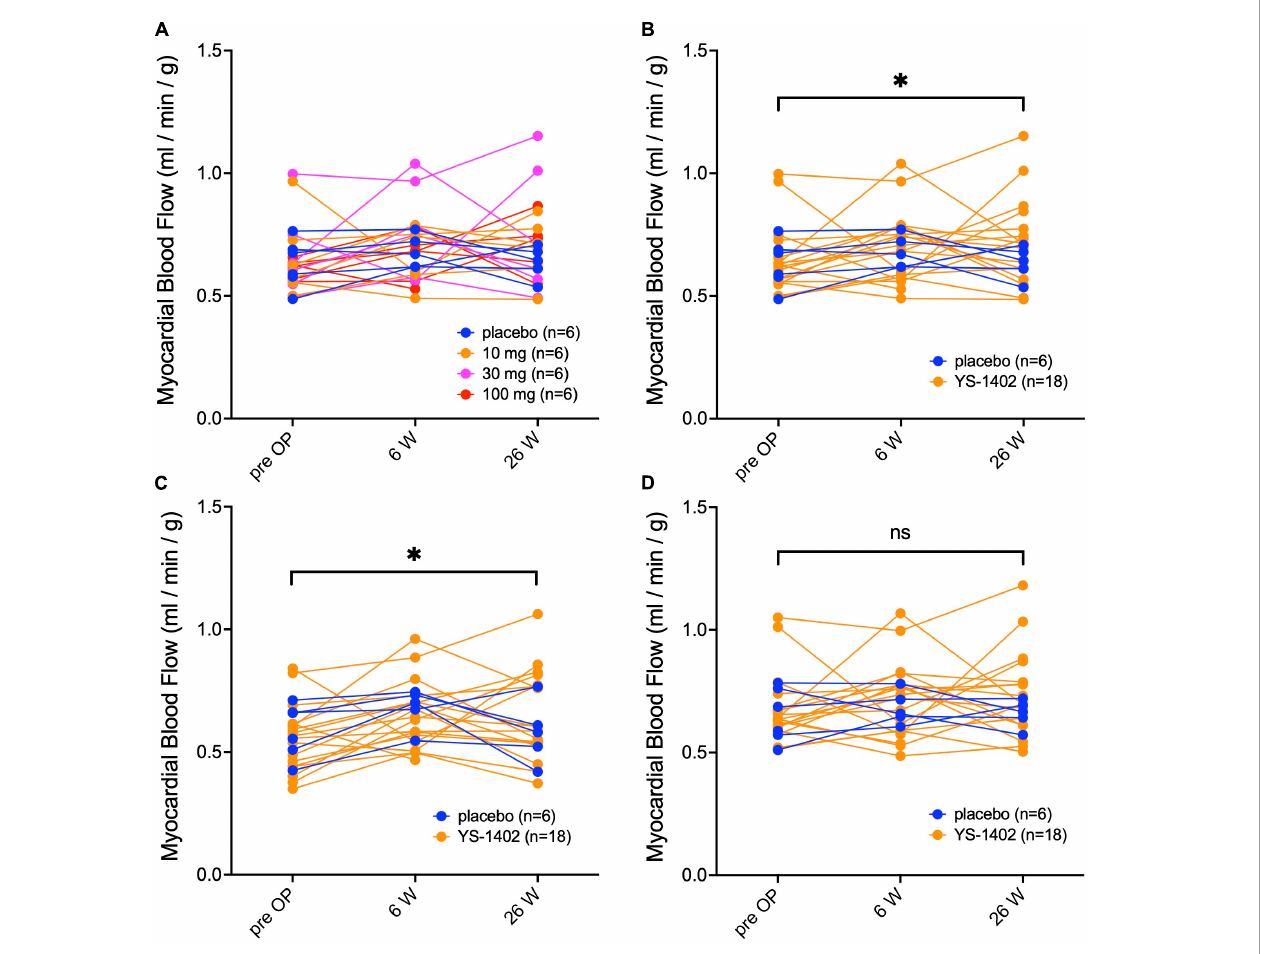
FIGURE3 Serial measurements of myocardial blood flow at rest. Serial changes in myocardial blood flow at rest measured with NH 3 -PET for the global region in each of the four groups (A) , the combined YS-1402/placebo group (B) , the region on which the YS-1402/placebo was placed [ (C) i.e., YS-1402 site], and the region on which the YS-1402/placebo was not placed [ (D) i.e., non-YS-1402 site] combined with the YS-1402/placebo group. The data are presented for each patient. ∗ p < 0.05 in the YS-1402 group between the preoperative and postoperative (i.e., at 26 weeks) values.